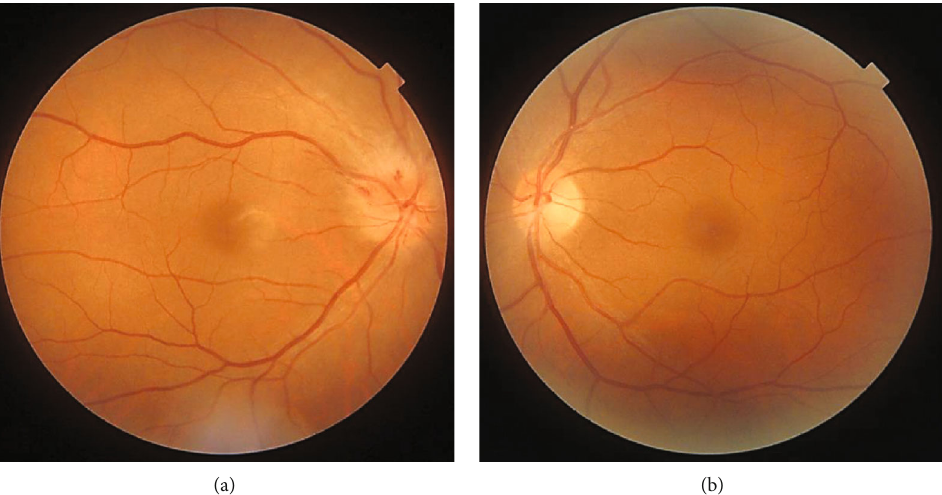
Figure 1: Photographs of the right (a) and left (b) fundus on initial examination. Note the di ff use optic disc swelling in the right eye, which was prominent above the optic disc.